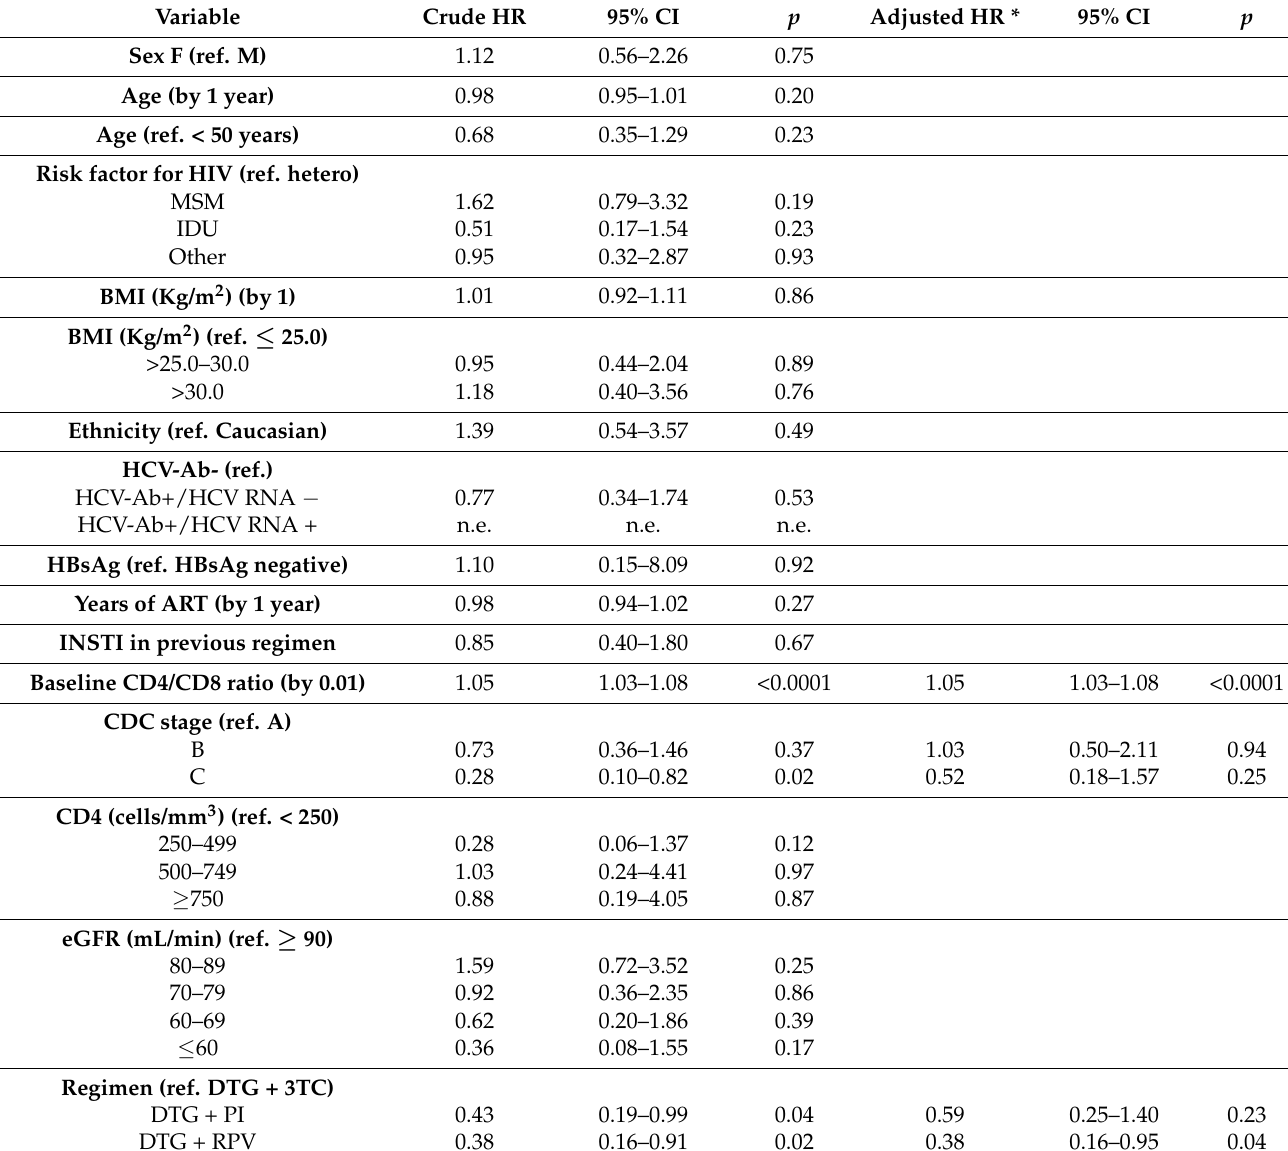
Table 5. Hazard Ratios for CD4/CD8 ≥ 1.0 among PWH on 2DR DTG-based regimens, according to baseline